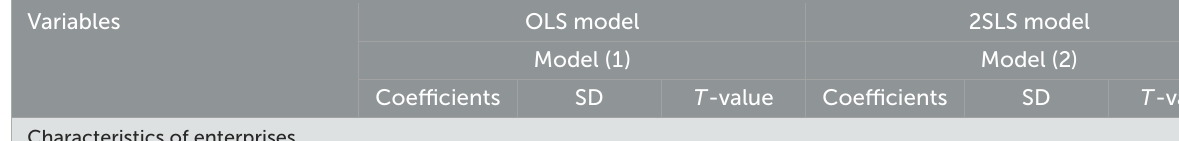
TABLE 4 2SLS method regression results of factors affecting the results of GMP inspection of pharmaceutical